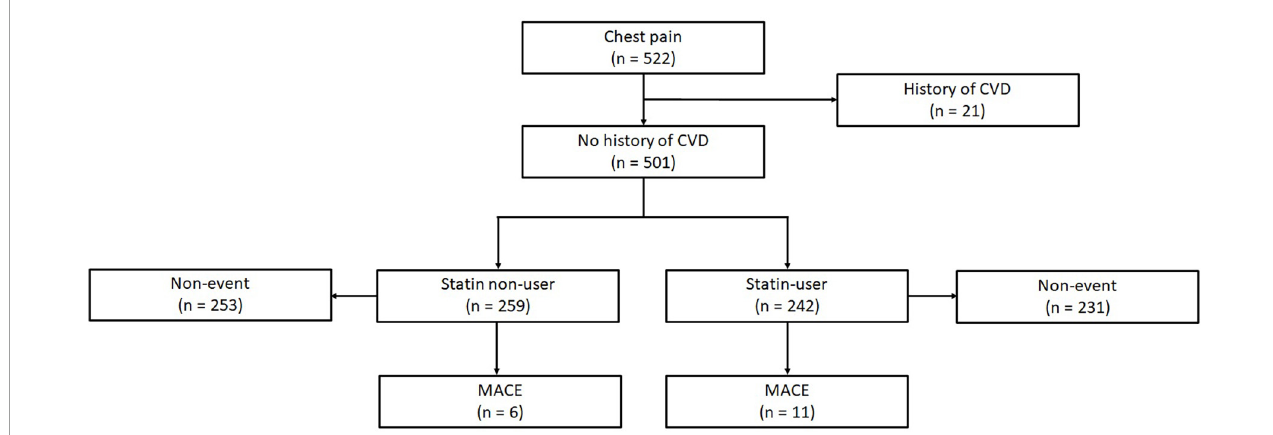
FIGURE1 Of 522 subjects with complete risk factor profiles, 21 participants were first excluded for prior history of ASCVD. 501 subjects were suitable for analysis, amongst which 259 were statin non-users with 6 events, and 242 were statin-users with 11 events. CVD, cardiovascular disease; CAC, coronary artery calcium; MACE, major adverse cardiovascular